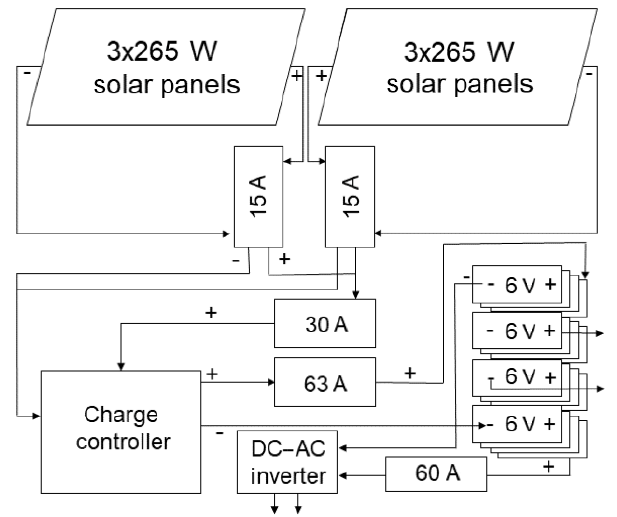
Figure 7. Schematic of the solar and power supply system with wiring and circuit breakers. Wires are noted positive ( + ) and neg- ative ( − ). Arrows from the DC–AC inverter supply 120V AC to power the N 2 O analyzer. Arrows from the battery back supply 12V DC. Circuit breakers are labeled by their ampere rating. Batteries for the battery bank are labeled by individual battery